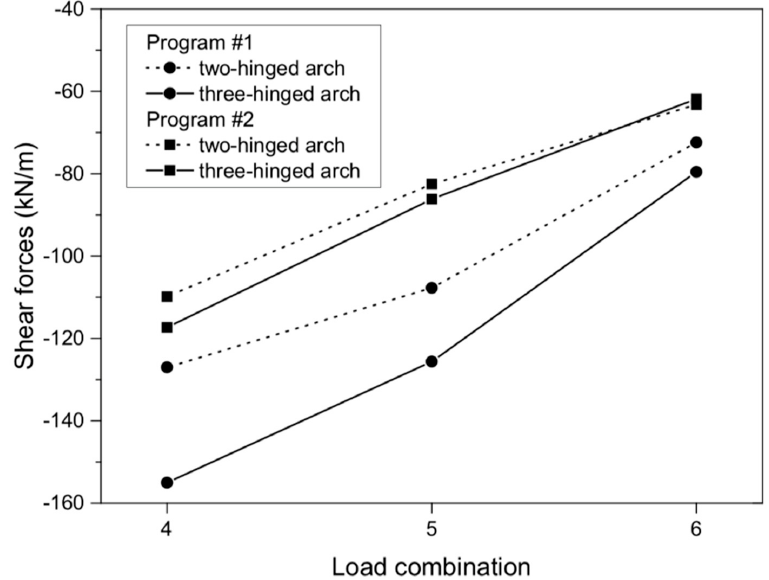
Figure 10. Shearing forces of masonry arch for load combinations.